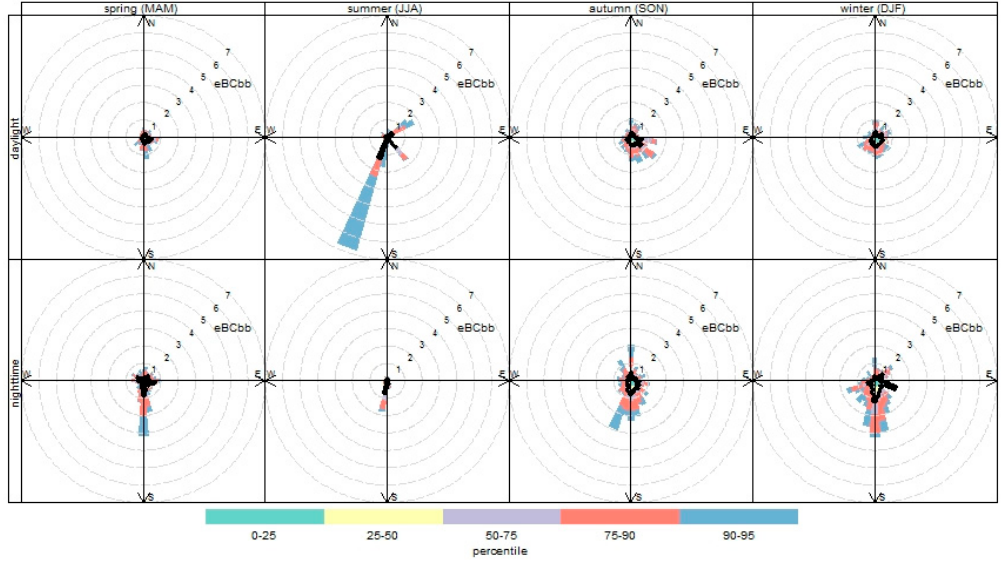
Figure 11. Percentile rose plot of eBCbb concentrations (µg m − 3 ).